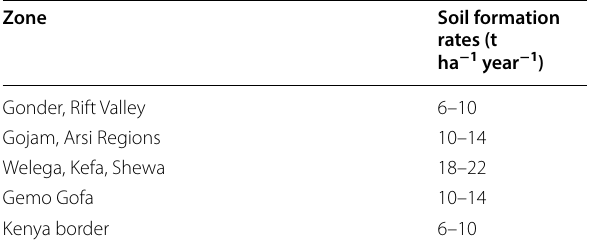
Table 8 Zonal variability of soil formation rates (Sources: Hurni 1993)